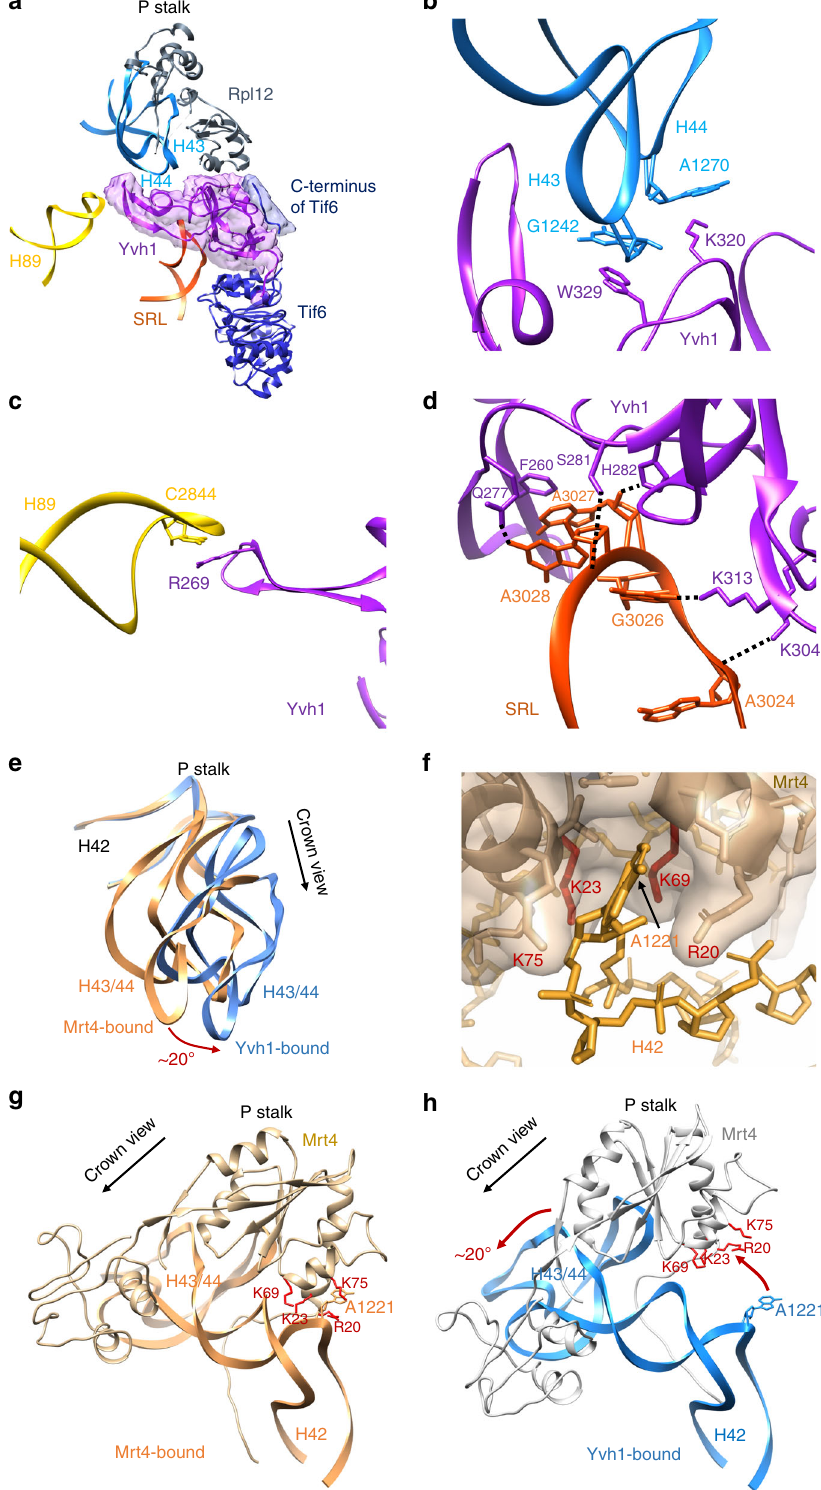
Fig. 2 Yvh1 forces the release of Mrt4. a Atomic structure of the zinc-binding domain of Yvh1 modeled into the unassigned density. The small piece of extra density (blue) was assigned to the C terminus of Tif6 (see Supplementary Fig. 7b). b – d Interactions of Yvh1 with helices H43 and H44 ( b ), helix H89 ( c ), and sarcin-ricin loop (SRL) ( d ). Dashed lines, predicted hydrogen bonds. e Comparison of the P stalk RNAs in the Mrt4-bound (orange) and Yvh1-bound (blue) states. f Mrt4 in cartoon and transparent surface representation. A1221 of H42 bound in a pocket of Mrt4. g Mrt4 bound to P stalk RNA rotated ~120° clockwise relative to the view in ( a ) showing A1221 of H42 in the binding pocket of Mrt4. Residues of Mrt4 interacting with H42 are indicated. h Mrt4 from the early cytoplasmic-immediate (ECI) particle was docked onto H43 and H44 of the Yvh1-bound pre-Lsg1 (PL) particle, showing the movement of Mrt4 away from A1221 of